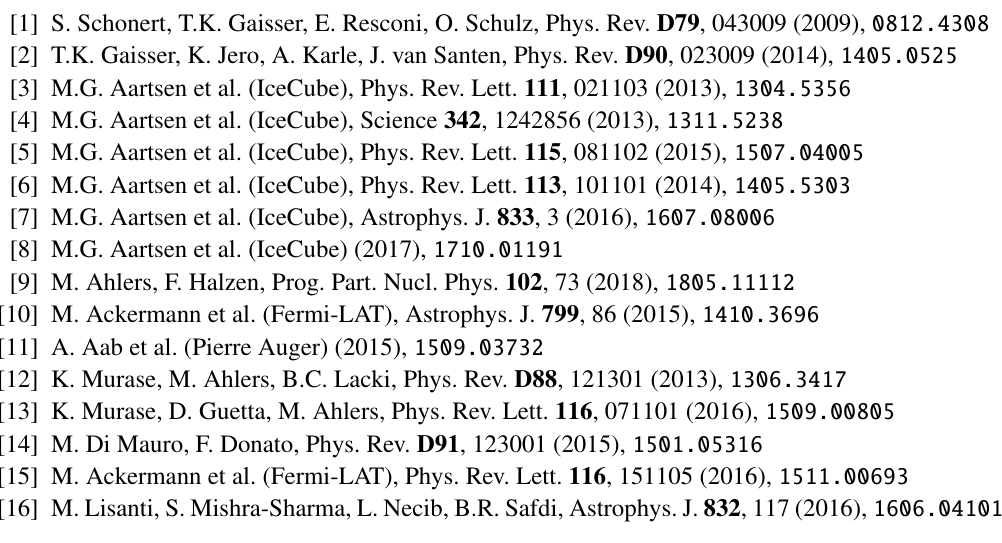
fitting time windows (durations T W ) over all times T 0 , with the height Fig. 1.Time-dependent analysis results. The orange curve corresponds Figure 3. The local p -values of past neutrino outbursts in the direction of TXS 0506 + 056. The orange and blue to the analysis using the Gaussian-shaped time profile.The central time T 0 indicating the significance of that window. In each period, the most significant time window forms a plateau, shaded in blue.The large blue and width T W are plotted for the most significant excess found in each line shows results using a Gaussian and box-shaped neutrino time-profile. The vertical dotted line shows the time band centered near 2015 represents the best-fitting 158-day time window period, with the P value of that result indicated by the height of the peak. of the alert IC-170922. (Figures from Ref. found using the box-shaped time profile.The vertical dotted line in IC86c The blue curve corresponds to the analysis using the box-shaped time indicates the time of the IceCube-170922A event. profile.The curve traces the outer edge of the superposition of the best-